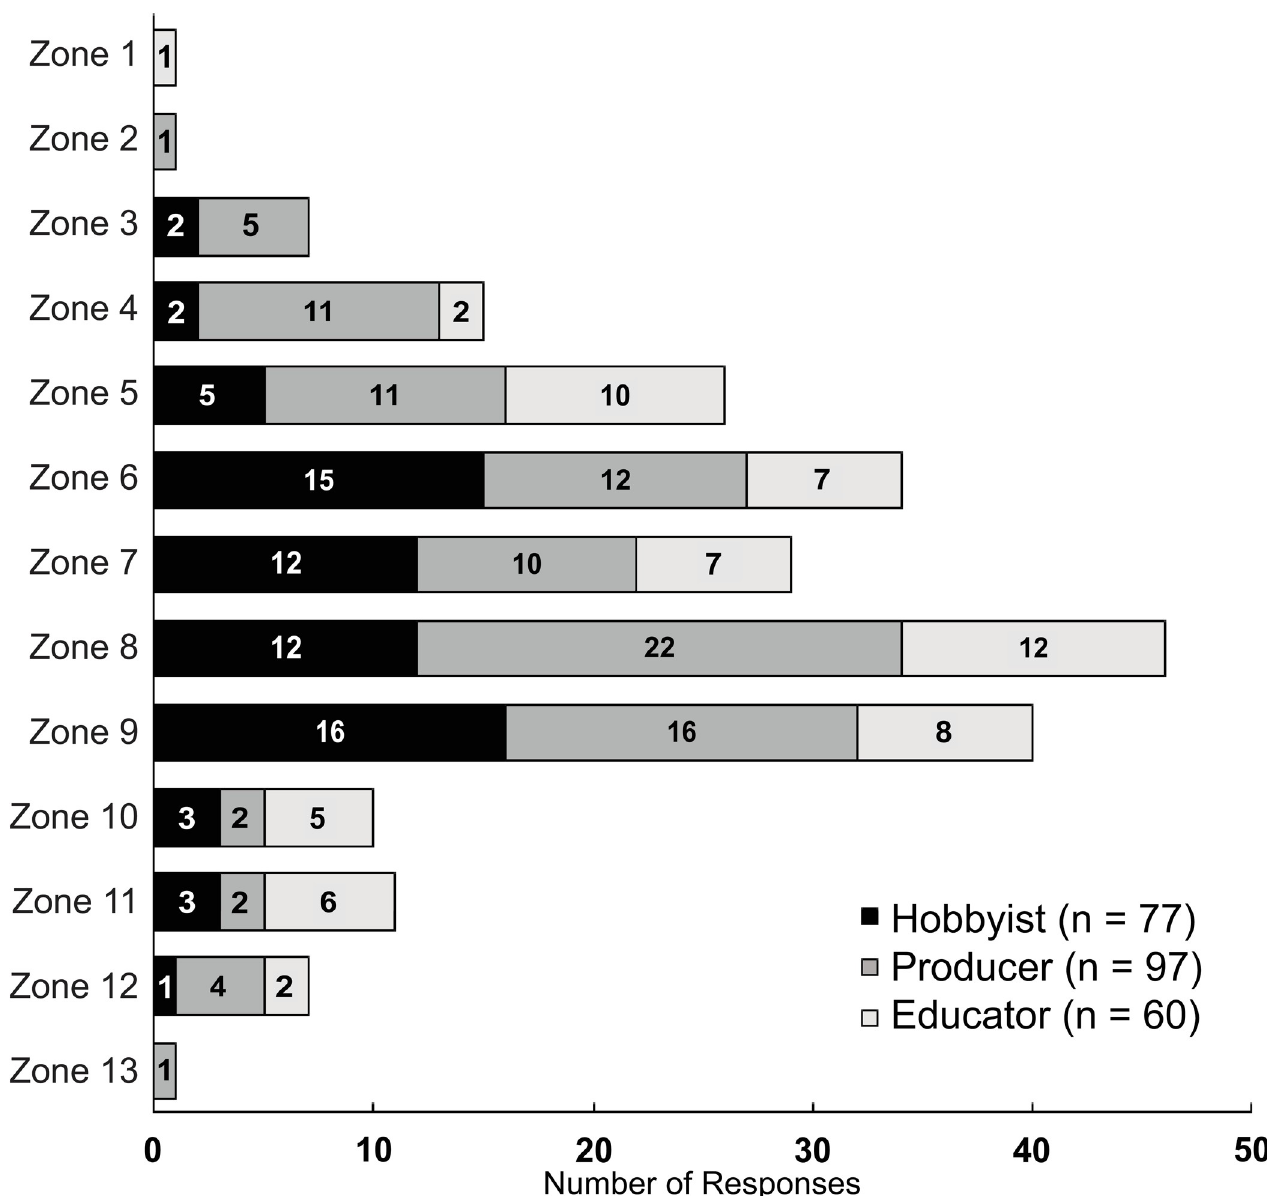
Fig 3. Number of U.S. survey respondents in each USDA plant hardiness zone. Zone 1 represents the most polar and zone 13 is the most tropical climates. Numbers preset within the bars represent the total number of respondents in a given zone for each stakeholder group.